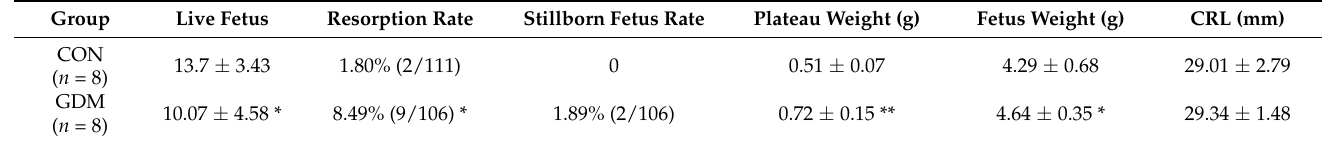
Table 1. The pregnancy outcomes of pregnant rats in CON and GDM